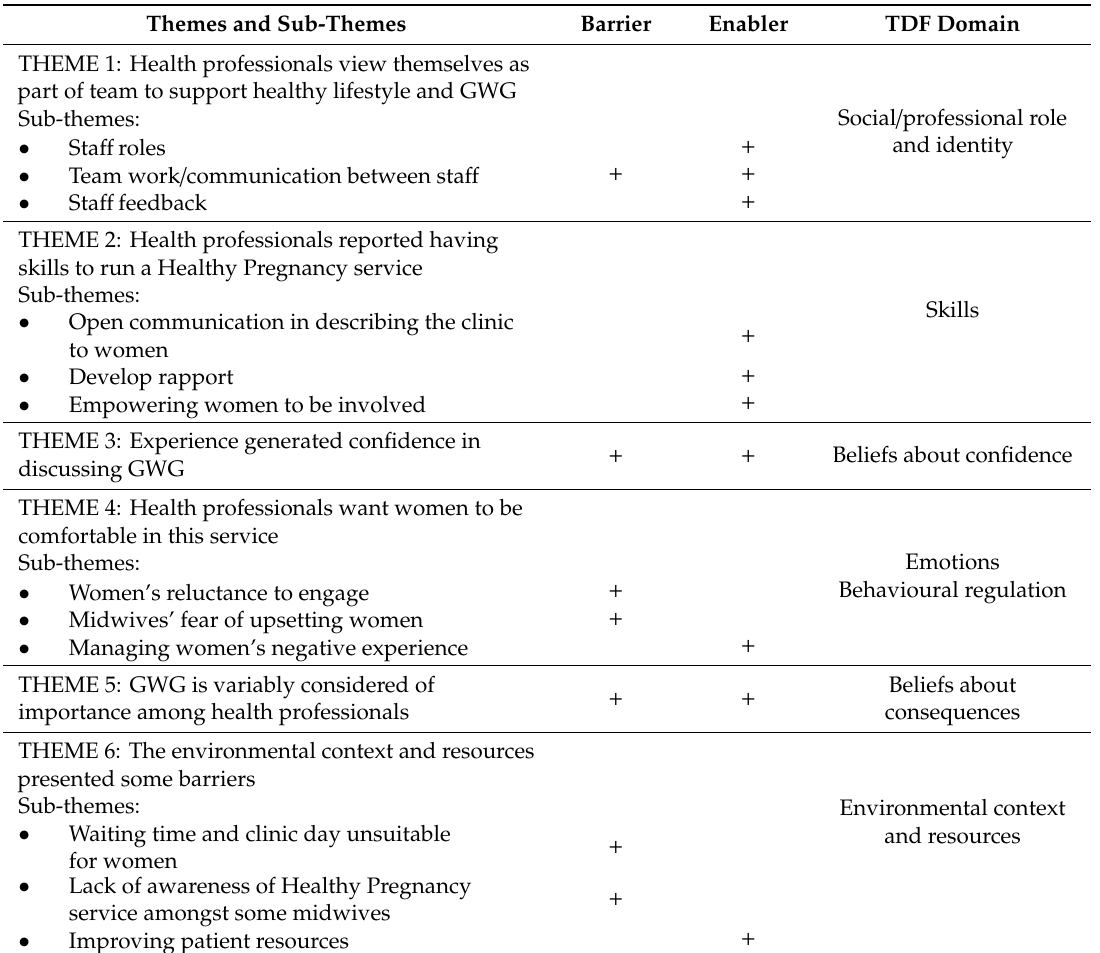
Table 3. Themes and sub-themes mapped to